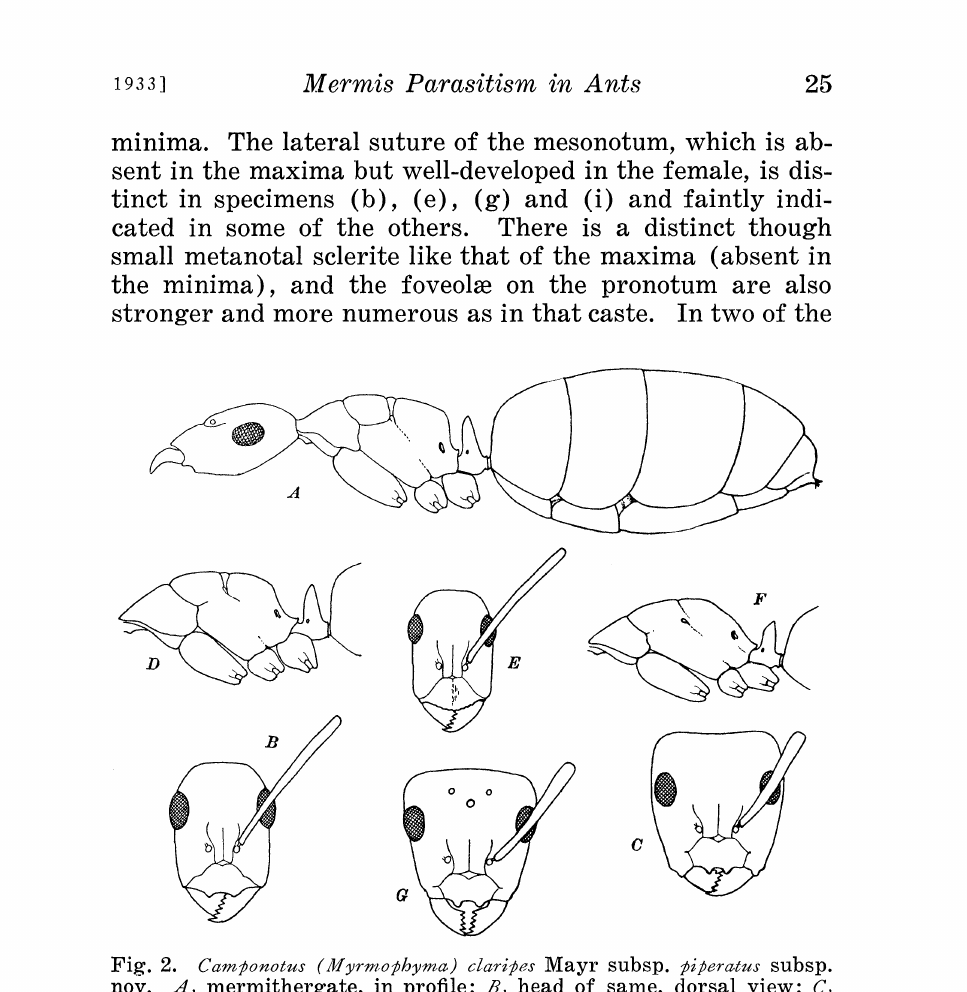
Fig. 2. Camponotus (Myrmophym) claripes Mayr subsp, piperctus subsp. nov. 4, mermithergate, in profile; 27, head of same, dorsal view; C, head of worker maxima, dorsal view; D, Thorax and petiole of same, in profile; 7, head of worker minima, dorsal view; F, thorax and petiole of same, in profile; G, head of female, dorsal